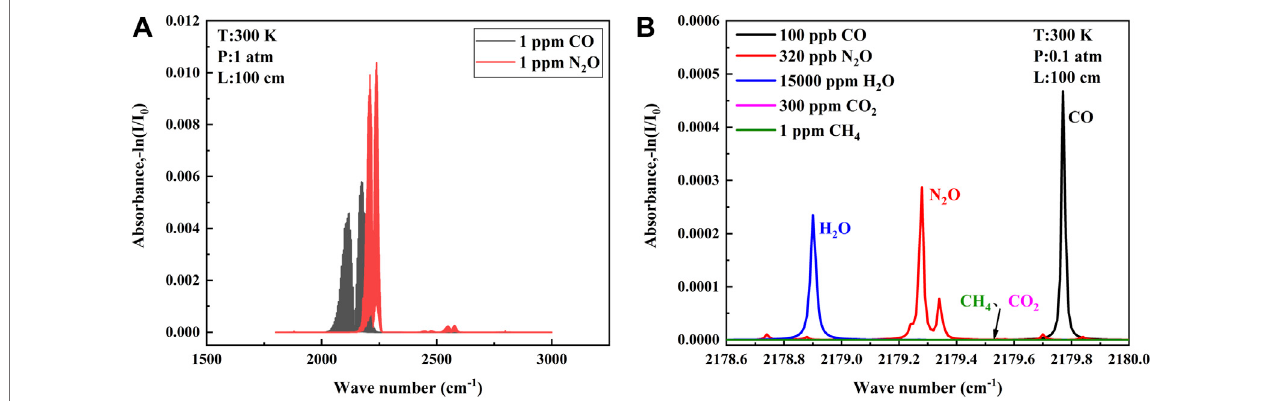
FIGURE 1 | (A) Absorption bands of CO and N2O provided by the database in the range of 1800-3000 cm − 1 . (B) Absorption lines of selected CO and N 2 O and other interfering gases at low pressure.